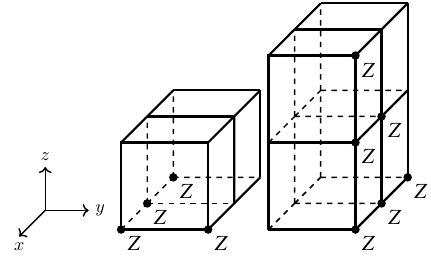
FIG. 8. The constraint terms of the ungauged CC1 in FSL